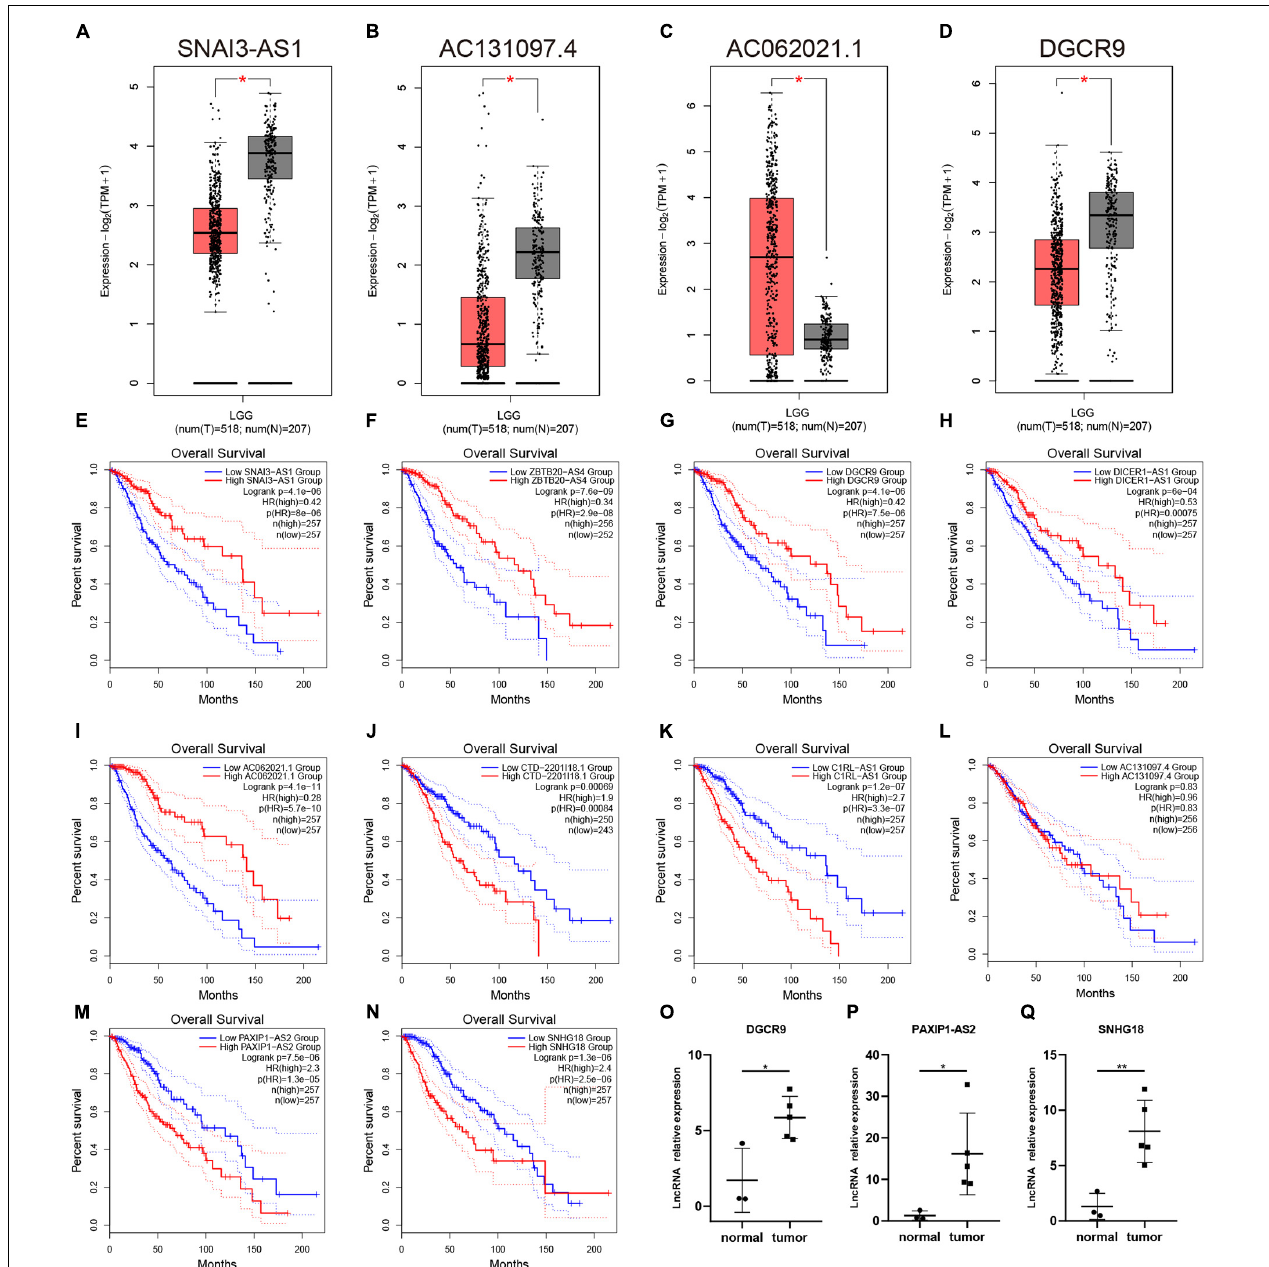
FIGURE 7 | The expression and prognostic analysis of a single lncRNA. (A–D) The expressions of SNAI3–AS1, AC131097.4, AC062021.1, and DGCR9 in the GEPIA analysis. (E–N) The survival curves of 10 lncRNAs. (O–Q) The expressions of DGCR9, PAXIP1-AS2, and SNHG18 in our collected samples. * p <